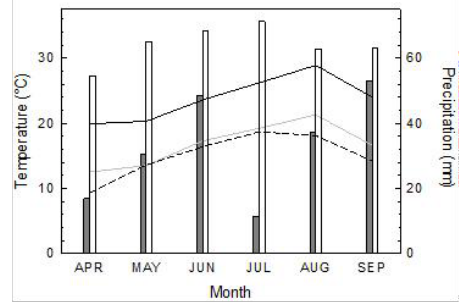
Figure 1. Monthly averages of maximum (solid black line) and mean temperature (grey line) and monthly sums of precipitation (grey bars) in spring and summer 2020, and long-term monthly averages (1981–2010) of temperature (dashed line) and precipitation (white bars) for comparison. In autumn 2020, the height and the stem diameter of the trees (5 cm above the soil surface; average of two measurements perpendicular to each other) were measured and their leaf buds were counted. All trees were attributed to classes of damage caused by drought stress based on the extent of leaf loss, as well as leaf and stem discolouration. By